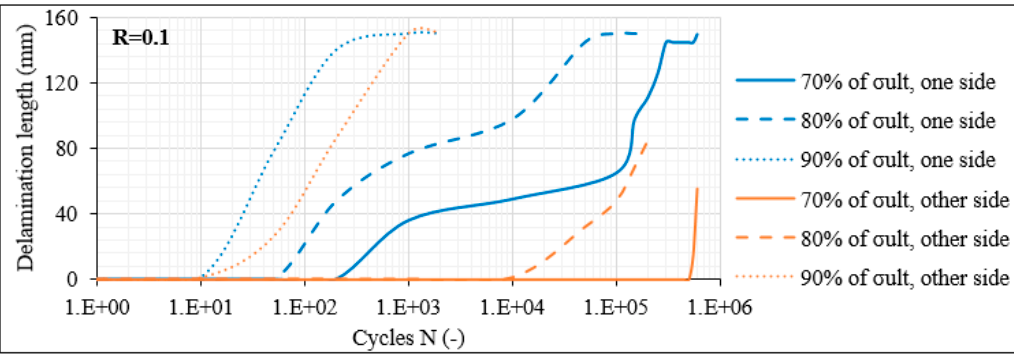
Figure 11. Matrix crack density versus N in [0 ◦ /60 ◦ /0 ◦ / − 60 ◦ ] s laminates for R = 0.1.